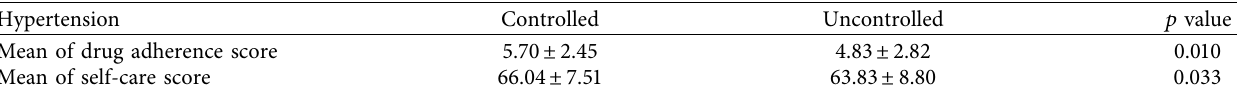
Table 3: The mean of drug adherence and self-care score in the individual with controlled and uncontrolled hypertension. A p value < 0.05 was considered significant.